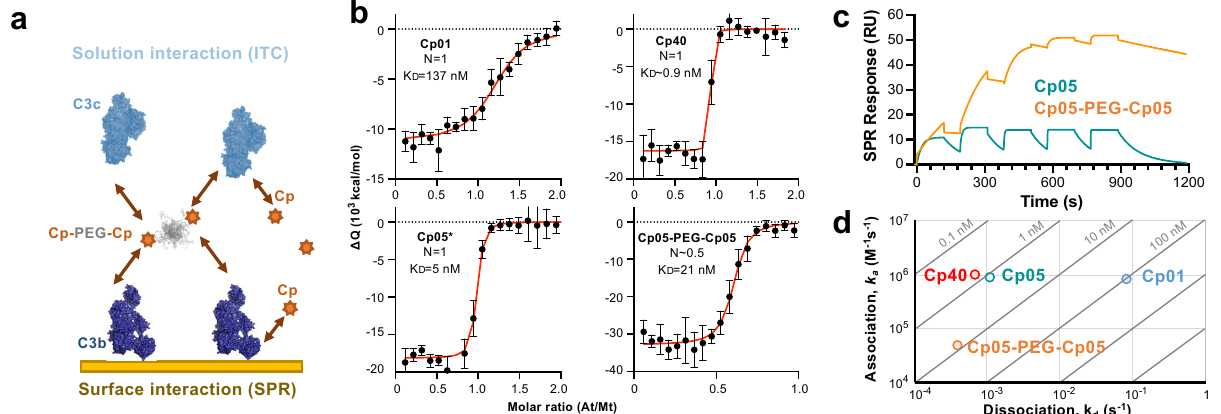
Fig. 6 | Differential interaction modes of mono- and bivalent compstatin ana- logs. a Compstatin-based drugs may interact with circulating (i.e., C3, C3c) or surface-tethered targets (i.e., C3b, C3bBb, iC3b). Depending on their valency, avidity may occur. b ITC analysis of solution interactions between C3c and comp- statin analogs Cp01, Cp05*, Cp05-PEG-Cp05, and Cp40 shows 1:1 binding for monovalent analogs ( N =1) whereas the data of the bivalent Cp05-PEG-Cp05 fi ts a 2:1 ratio ( N =0.5). The displayed curve is a representative of two independent experiments per compound, obtained by peak-to-peak integration of the pro- cessed thermogram, as a function of At/Mt (titrant-to-titrate molar ratio). The integrated signal (black) is fi tted to a 1:1 binding model (red curve) for determi- nation of af fi nity (K D ) and molecular ratio( N ). Error bars represent the uncertainty